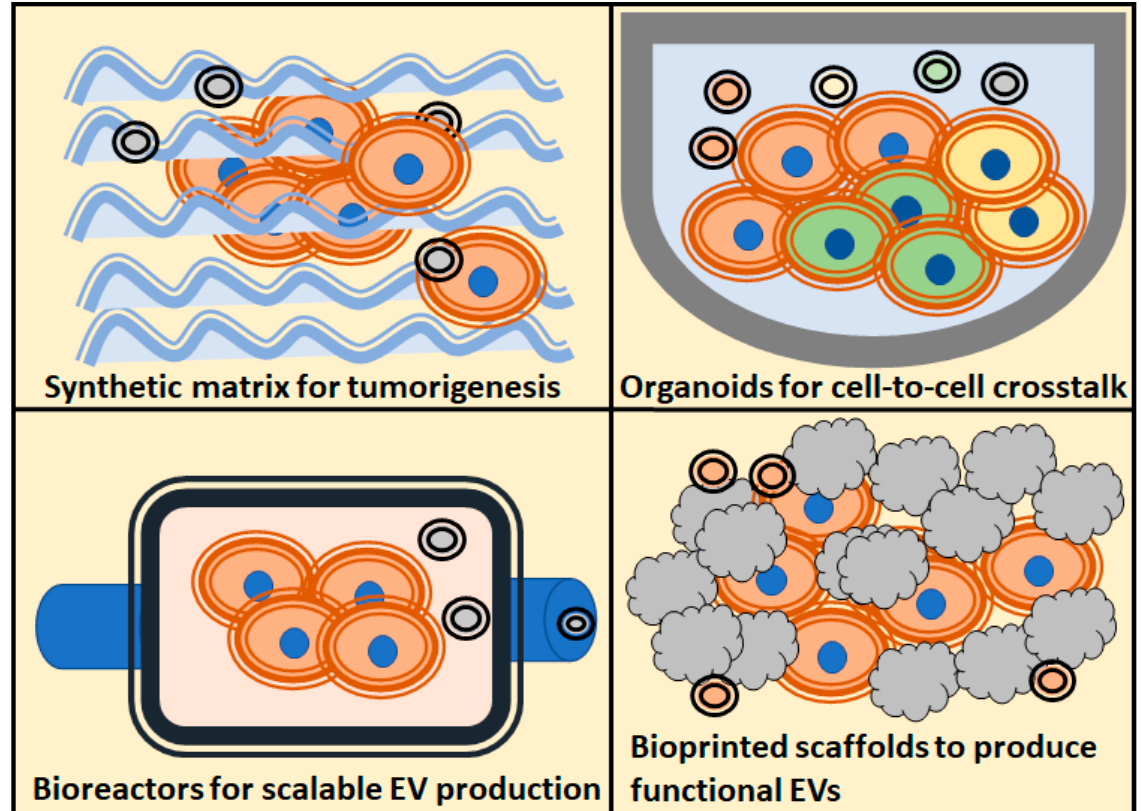
Figure 1. Schematic overview of the most popularized 3D culture techniques, and the main assays regarding extracellular vesicles (EVs) applications to the study of tumors biology, use of EVs as therapeutic agents, study of tumorigenesis and cell-to-cell crosstalk.